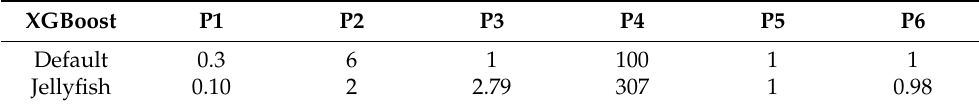
Table 4. Selected